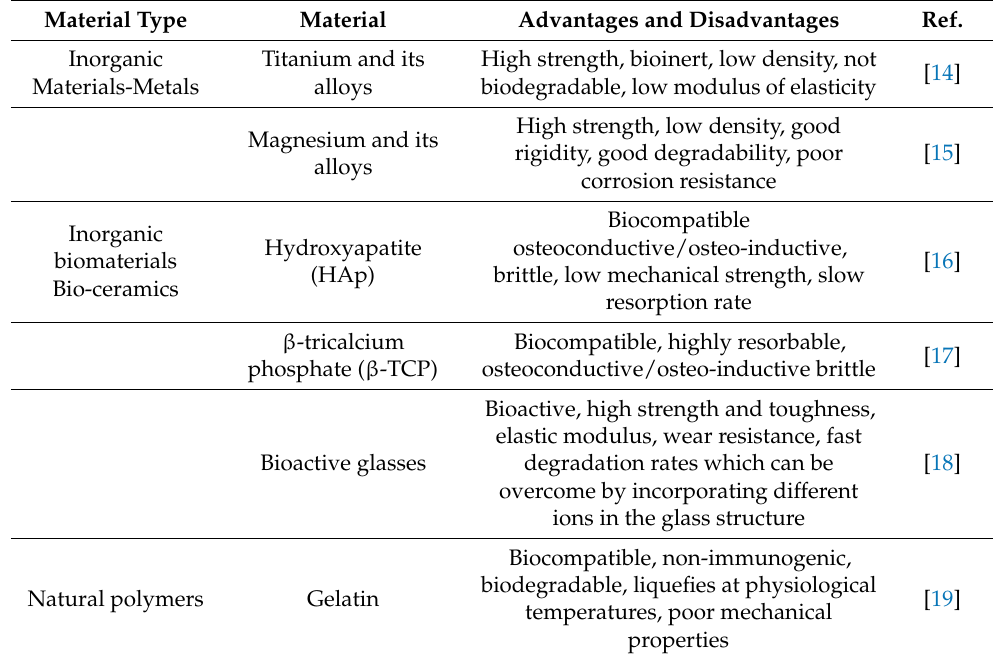
Table 1. General properties of commonly used biomaterials in BTE